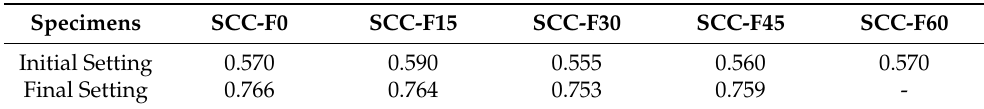
Table 4. CR1 calculated at initial and final settings for SCC specimens with different FA replace- ment